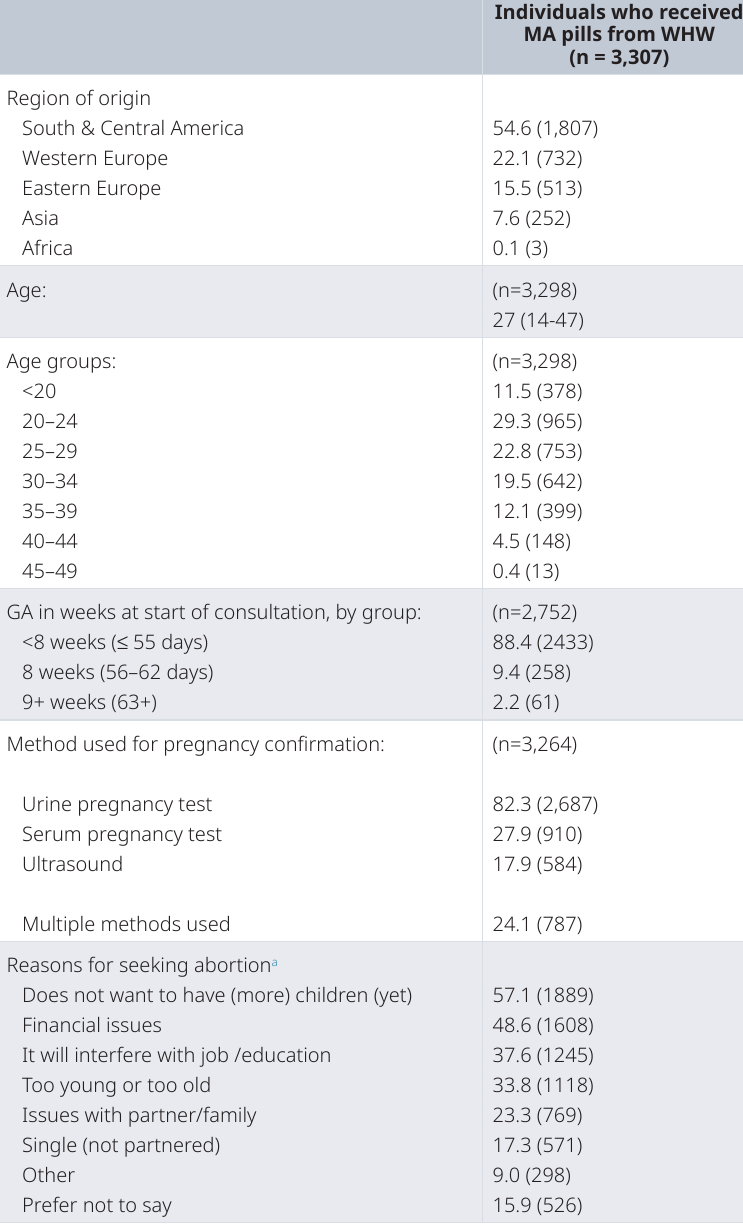
Table 1. Demographics and background information for all individuals who completed online consultation and received MA pills from WHW %(n) or median